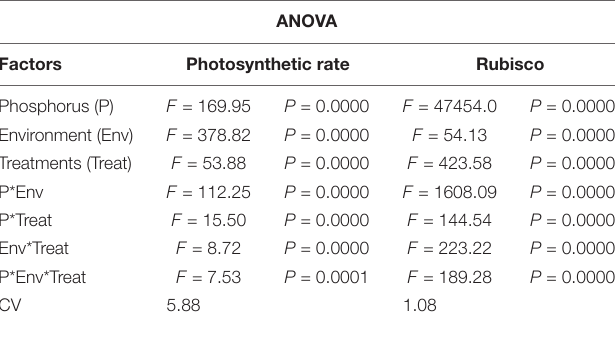
TABLE 3 | Values under ANOVA are the F-test, probabilities ( P value) and coefficient of variation of the sources of variation (LSD, P <